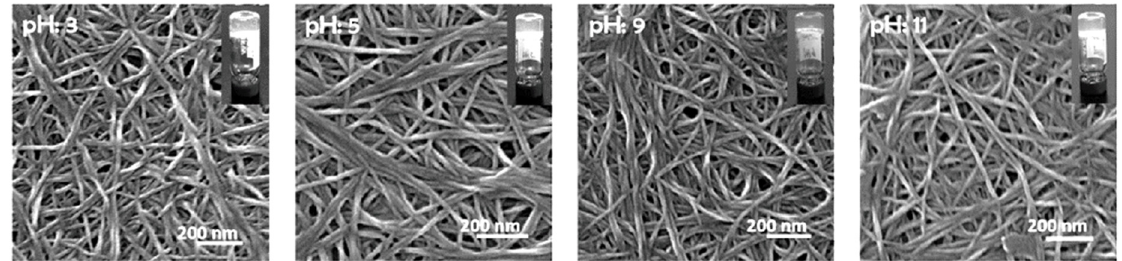
Figure 4. SEM images and photographs (insets) of the gels formed by cyclo(Phe-Leu) at various pH values. Adapted with permission from [101], copyright © 2019,